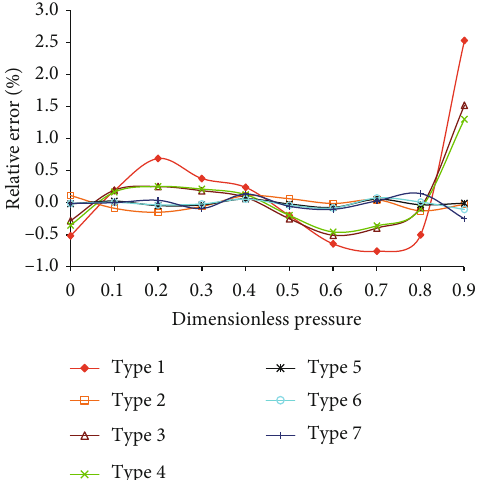
Figure 6: Relative error analysis of in fl ow performance equation fi tting for seven types of 60 ° inclined wells.